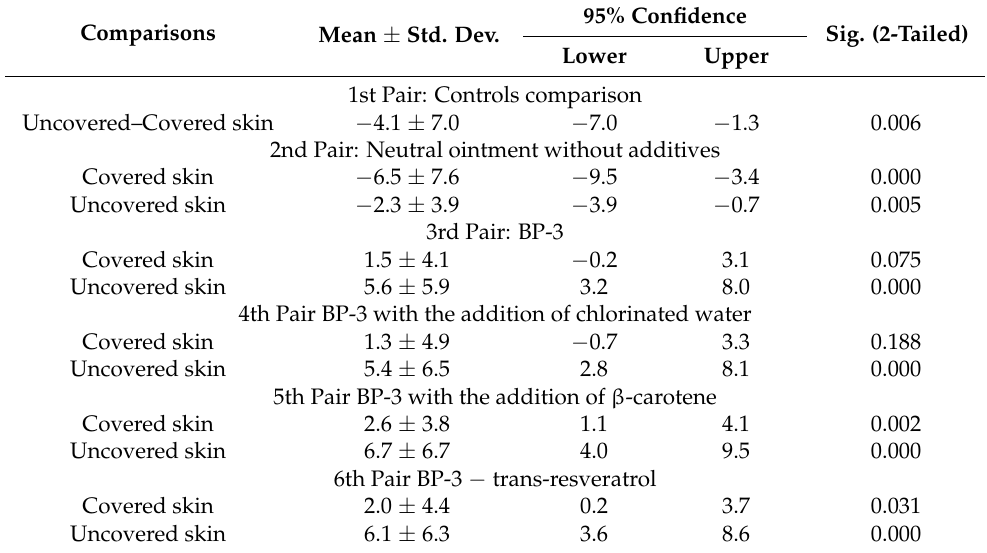
Table 4. The paired sample test – the comparison between skin squares and the covered/uncovered skin in the clinical